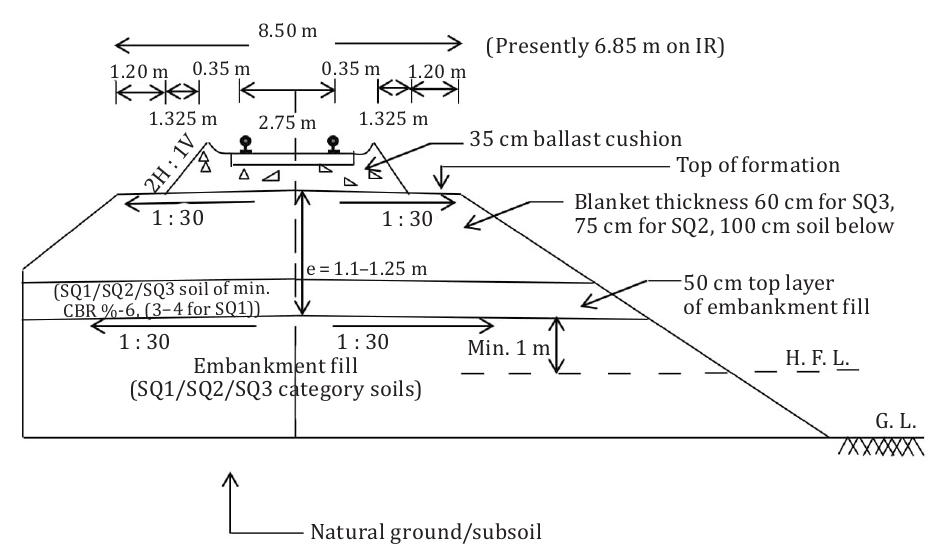
Natural ground/subsoil Figure 1. Indian railway embankment section as per GE-14, 2008